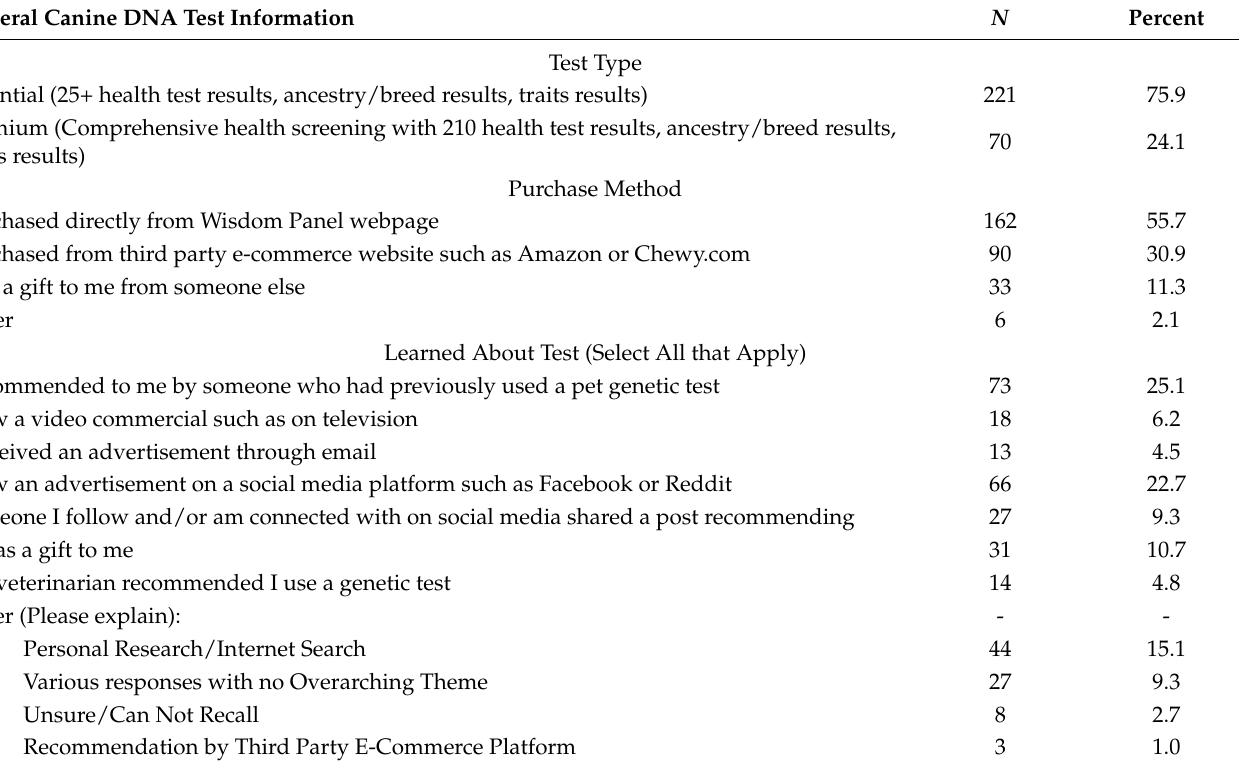
Table 3. Description of test type, purchase method, and how participant learned about Wisdom Panel canine genetic services.